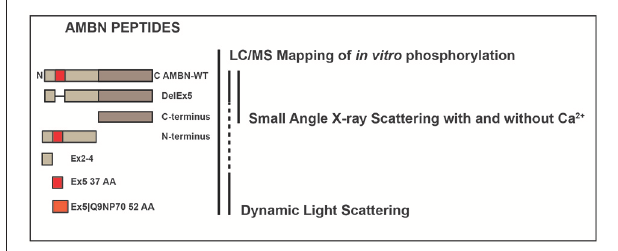
FIGURE 1 | The experimental design indicating the various recombinant AMBN proteins and peptides and test methods used in this study. Recombinant human AMBN-WT, N-terminus, C-terminus, DelEx5, Ex2-4, Ex5 proteins, and peptides were tested with LC-ESI-MS mapping of all peptides phosphorylated in vitro , dynamic light scattering (DLS) of Ex5, Ex5|Q9NP70, AMBN-WT, and DelEx5 and small angle x-ray scattering (SAXS) of AMBN-WT, DelEx5, and C-terminus with and without Ca 2 +